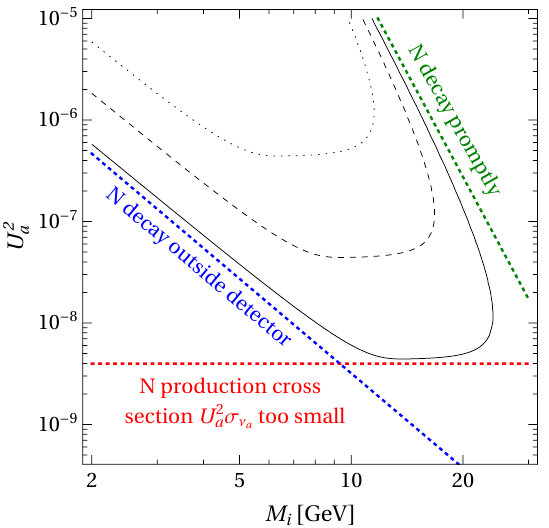
Figure 4. A simpli(cid:12)ed sensitivity estimate based on the analytic approximation (2.2) using l 0 = 5 mm and l 1 = 3 m illustrates the three main obstacles in improving the sensitivity (colored dotted lines). The three black sensitivity curves correspond to nine expected events for integrated luminosities of 3, 30, 300 fb (cid:0) 1 , and we have assumed that all e(cid:14)ciencies are 100 %. M (cid:29) 5 GeV the N decay width only depends on U 2 and M , it can be estimated as a